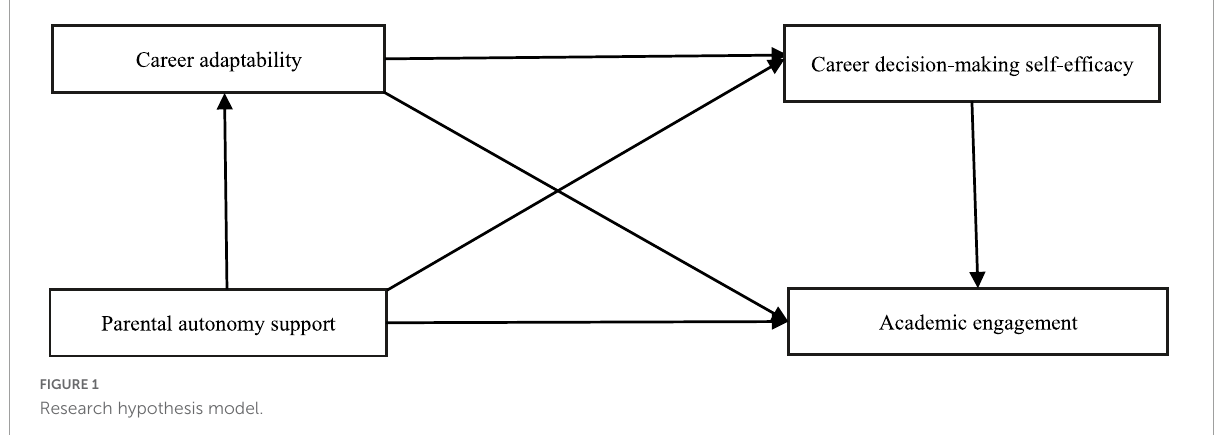
FIGURE1 Research hypothesis